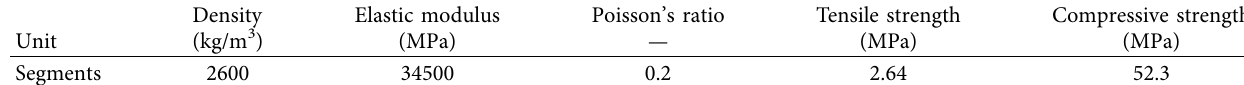
Table 2: The mechanical and physical parameters of the underpass segments.